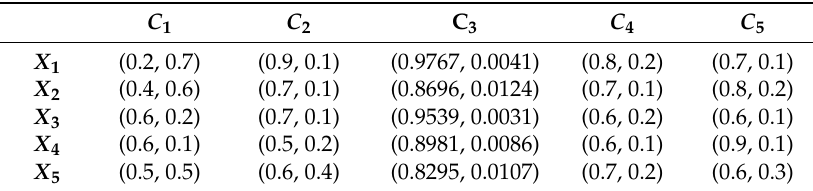
Table 8. Intuitionistic fuzzy decision matrix D 3 .